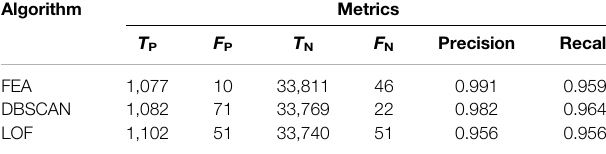
TABLE 5 | The outlier detection results in real-world scenarios.